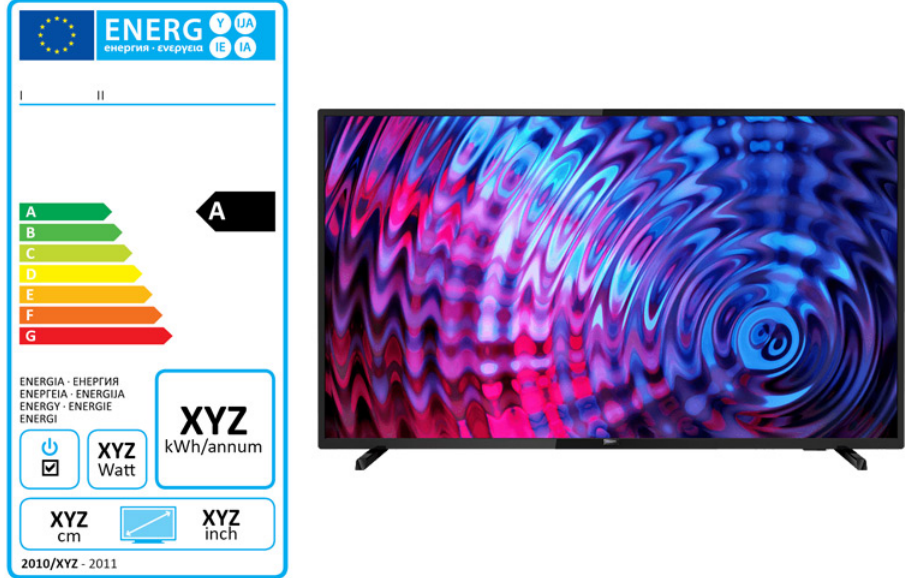
Fig. 15. – ErP-label for products.